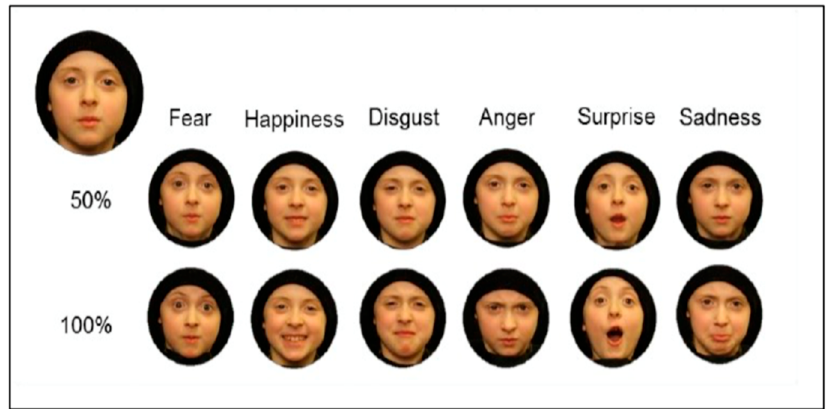
Figure 2. Example of the facial expression stimuli of the six emotions (happiness, surprise, fear, sadness, anger and disgust) at two levels of intensity (pure emotional expression and merged between neutral and emotional expression).